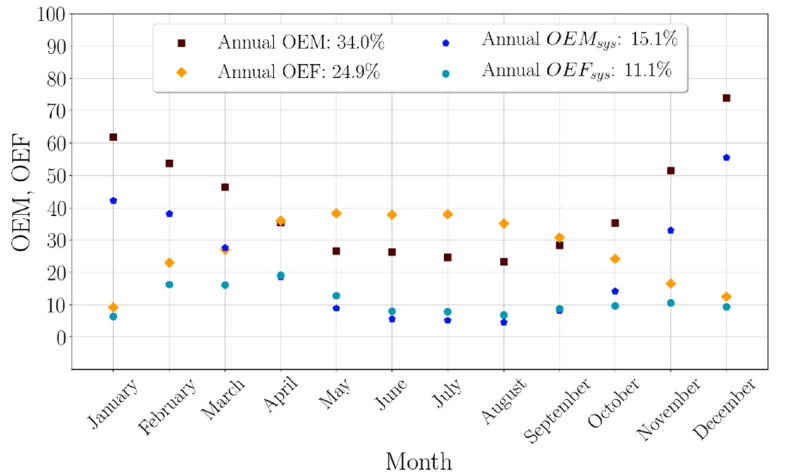
Figure 22. Monthly and annual On-site Energy Fraction ( OEF ) and On-site Energy Matching ( OEM ). A distinction is made between the OEF and OEM including and excluding (system) the domestic electricity demand.